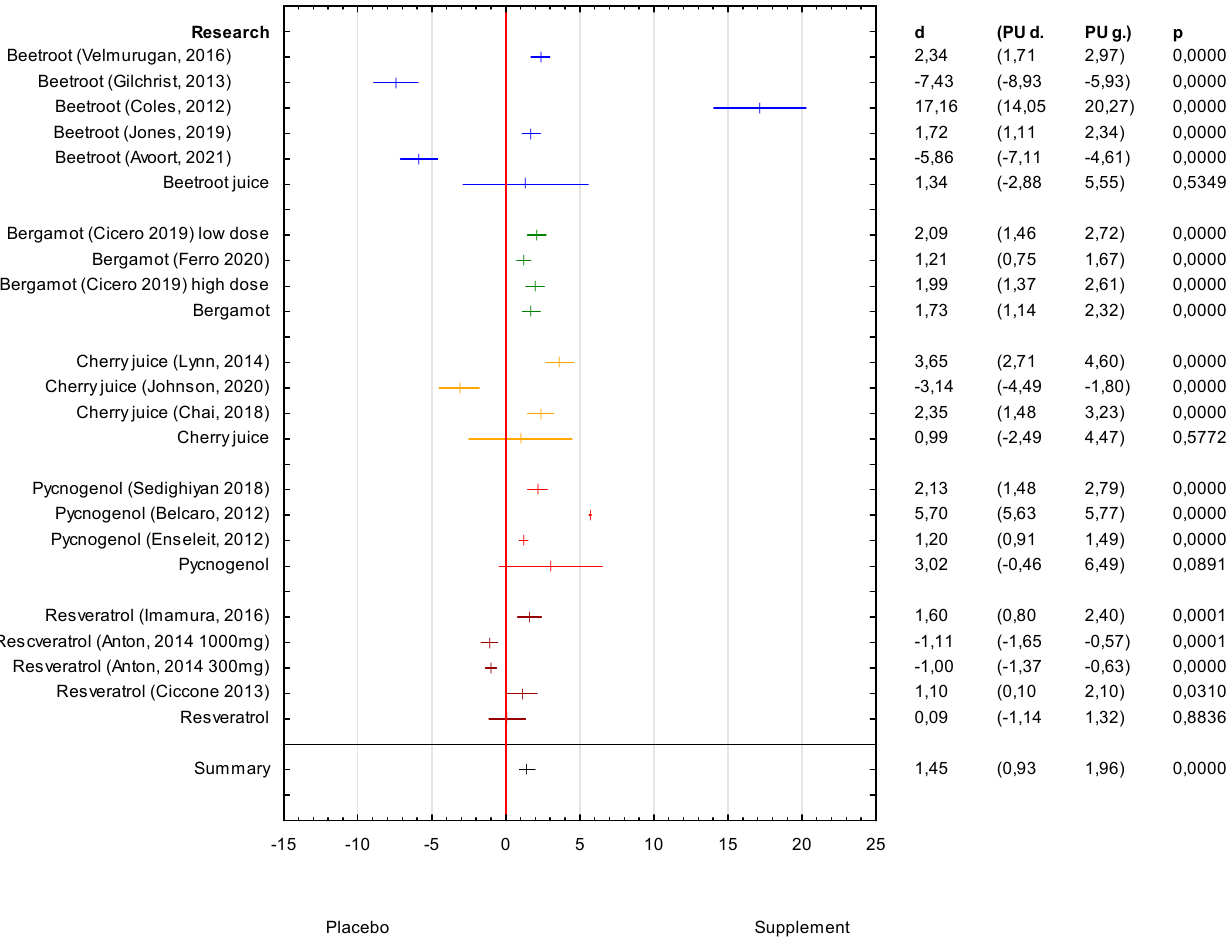
Figure 2. Forest plot of the results of the meta-analysis for supplement effectiveness on SBP versus the placebo group. Data are shown as mean effect sizes with 95% CI.